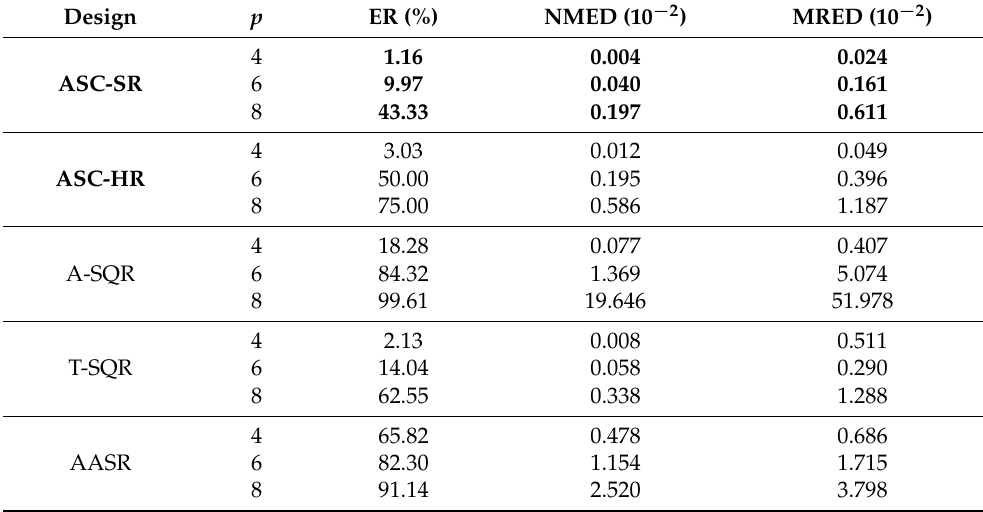
Table 2. Accuracy evaluation results (proposed designs and best accuracies shown in bold font). Design